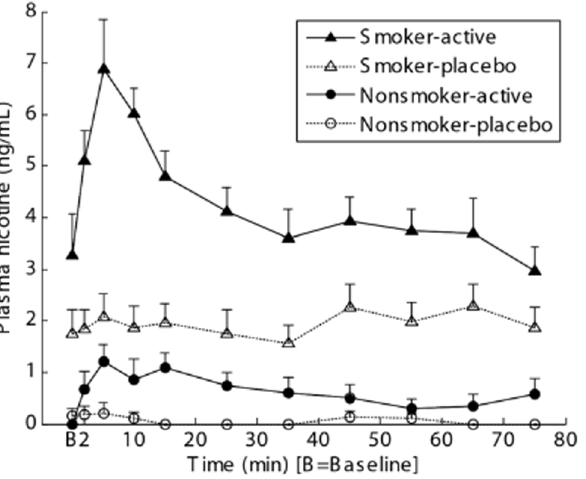
Fig. 1. Line plots of mean concentrations across subjects of nicotine in plasma versus time of active and placebo cigarette scans. PET data acquisition began between 5 and 10 min on the time axis in individual